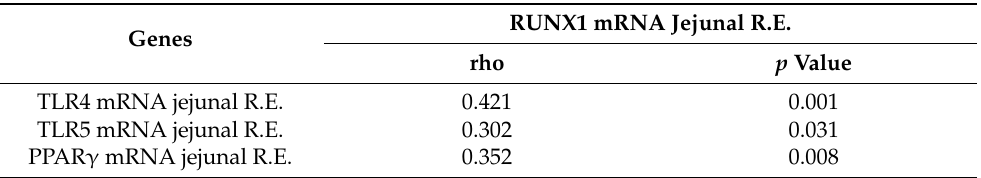
Table 2. Significant correlations between the RUNX1 relative jejunal expression and other genes in the jejunum. RUNX1 mRNA Jejunal R.E. Genes rho p Value TLR4 mRNA jejunal R.E. 0.421 TLR5 mRNA jejunal R.E. PPAR γ mRNA jejunal R.E. 0.352